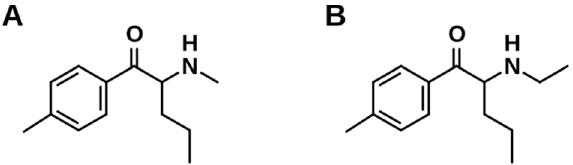
Figure 1. Chemical structures of the investigated synthetic cathinones. ( A ) = 4-MPD and ( B ) = 4-MEAP.